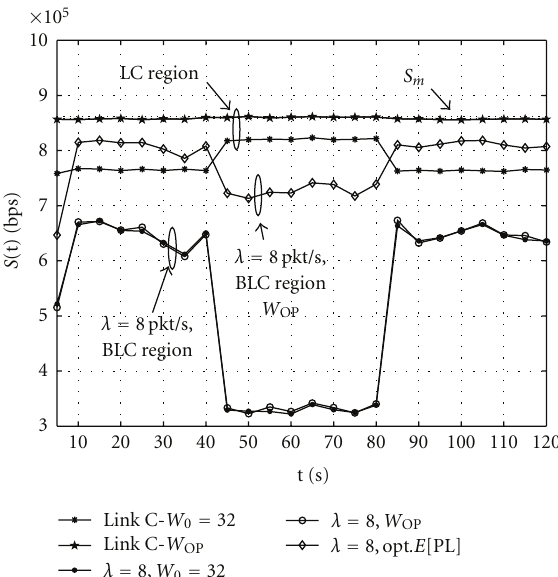
Figure 9: Aggregate throughput of a network with a maximum number of stations equal to 10, transmitting at the fixed bit rate 1Mbps. Curve S m represents the maximum link capacity evaluated through (13). The other network parameters are described in the paper. Curves labeled LC region refer to a scenario whereby the contending stations transmit with packet rate λ = 10 3 pkt/s. In all the scenarios investigated in the figure, during the time intervals [0,40]s and [80,120]s ten stations contend for the channel, while in the time interval [40,80] s only 5 stations are active. Curves labeled ( λ = 8 pkt/s, BLC region) refer to a scenario whereby the contending stations operate in the BLC region. In this situation, the optimization of the contention window does not improve the aggregate throughput and the two curves are superimposed. In the BLC region, the aggregate throughput can be improved by varying the transmission packet size as emphasized by the curve labeled ( λ = 8pkt/s, BLC region, W OP